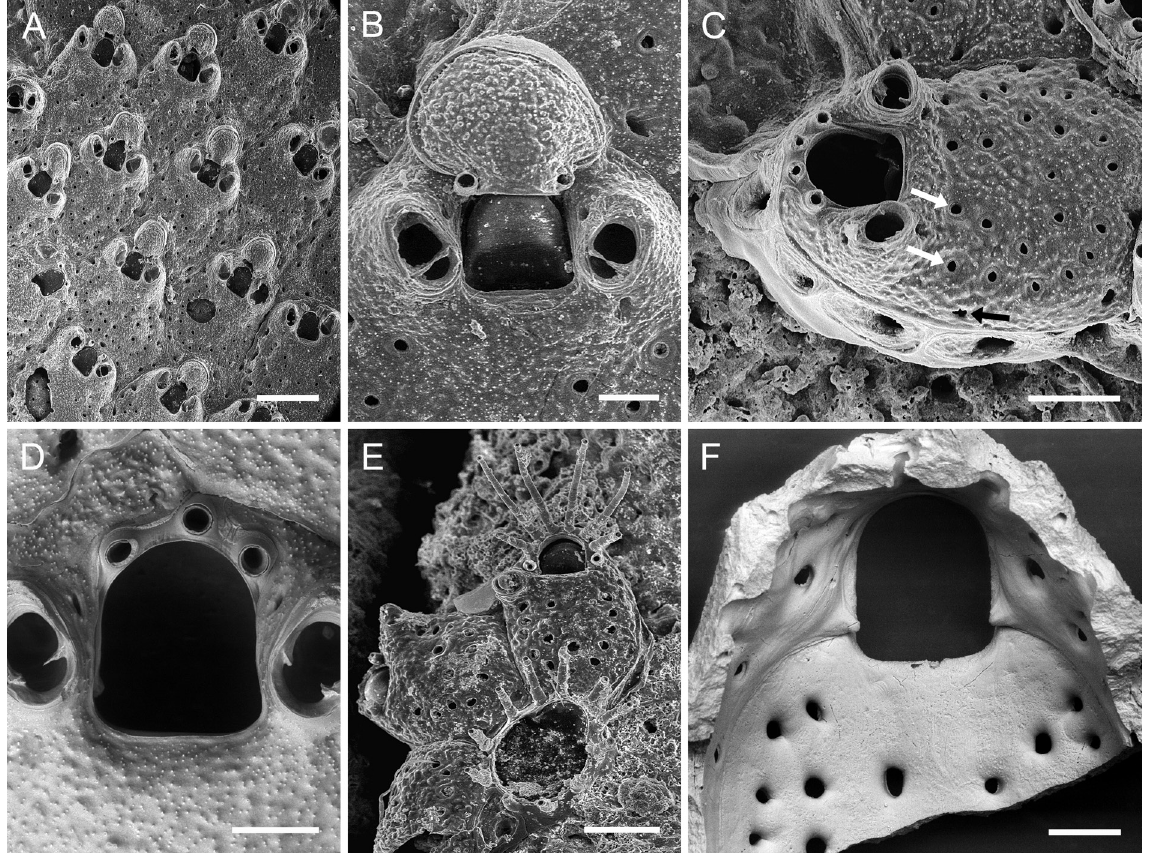
Fig. 14. Calvetopora otapostasis gen. et sp. nov., Atlantis Smt. A . Overview of the holotype (MNHN- IB-2014-78). B . Close-up of an ooecium and the suboral avicularia (holotype MNHN-IB-2014-78). C . Slightly oblique view of an autozooid at the growth margin showing the communication pores in the lateral walls as well as marginal areolar pores (black arrow) and the roughly crescentically arranged pseudopores (white arrows) in the frontal shield (paratype MNHN-IB-2014-280). D . Close-up of orifice; note that the condyles are so short that usually only one can be seen (paratype OLL 2016/153). E . Ancestrula and early astogenetic autozooids (paratype MNHN-IB-2014-81). F . Interior frontal shield showing the lateral areolar pores and the central pseudopores (paratype OLL 2016/153). Scale bars: A = 500 µm; B, D, F = 100 µm; C, E =